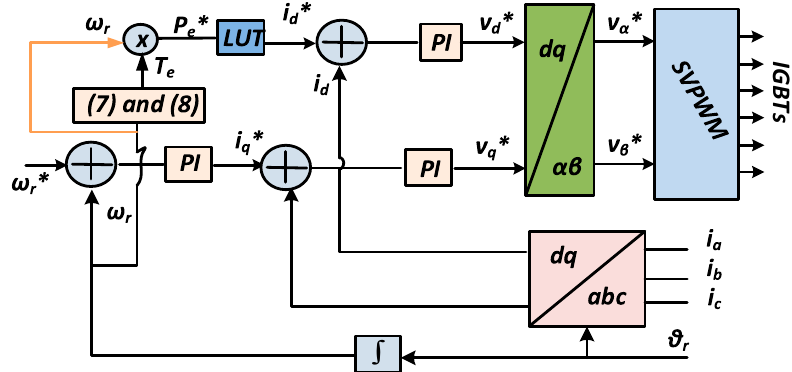
Figure 8. Diagram of the vector control strategy (VCS).